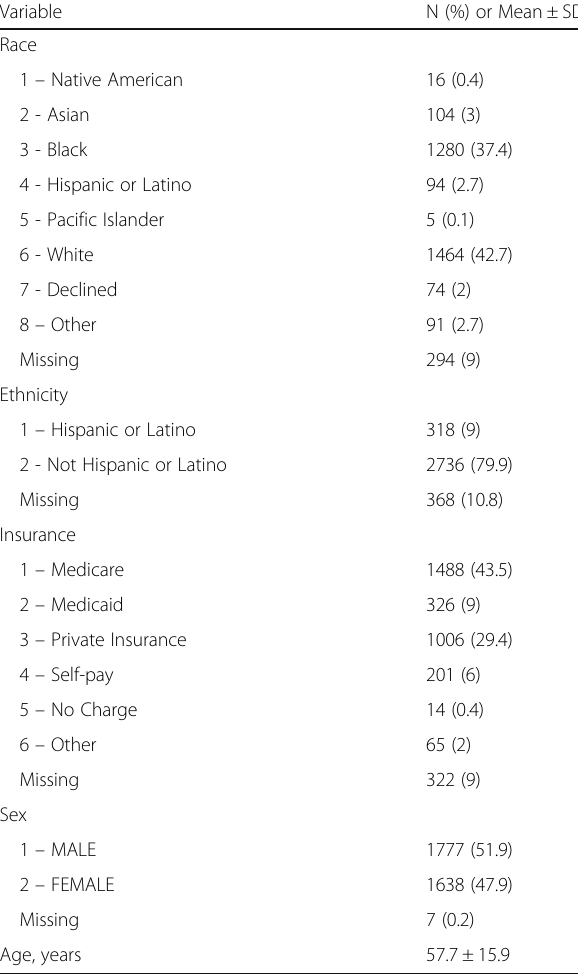
Table 1 Demographics of the 3422 patients in the Multi-Center cohort